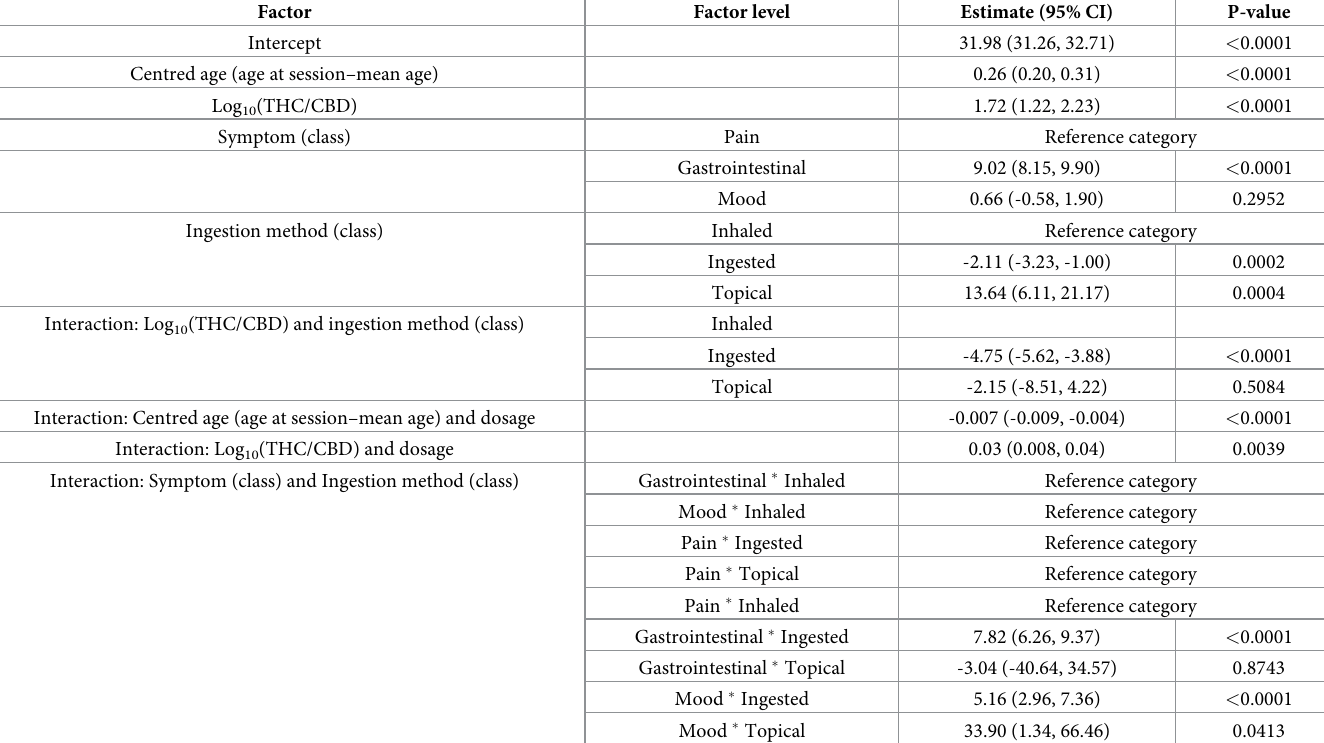
Table 2. Final model